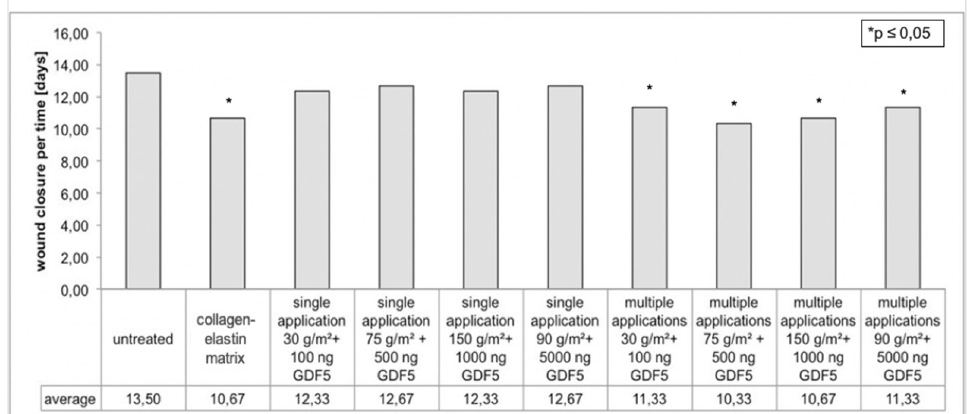
Figure 1. Planimetric analysis. The time required for complete wound closure of the untreated control group ( n = 6), the collagen–elastin matrix-treated group ( n = 6), and the groups treated once or multiple times with the novel composite biomaterial ( n = 6 for each condition).